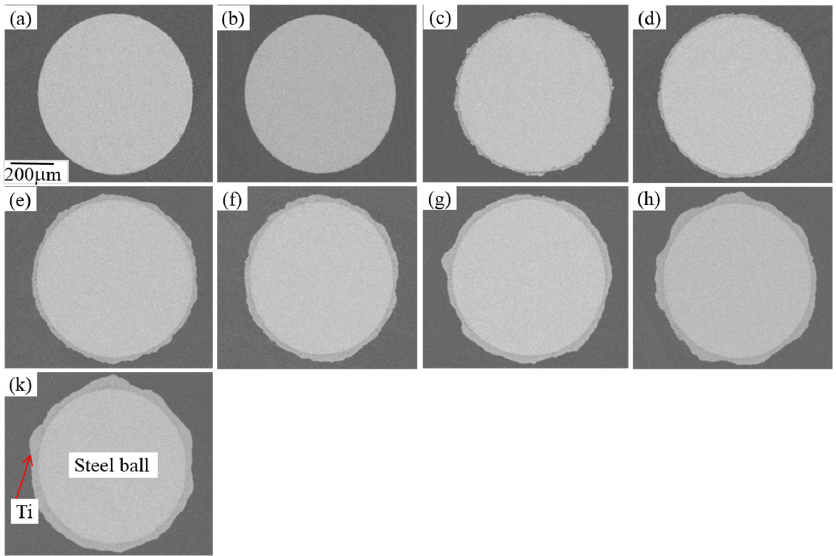
Figure 3. SEM images for the cross ‐ section of the samples prepared by mechanical coating at 300 rpm after different durations: ( a ) 4 h; ( b ) 8 h; ( c ) 10 h, ( d ) 12 h; ( e ) 16 h; ( f ) 20 h; ( g ) 26 h; ( h ) 32 h; and ( k ) 50 h.